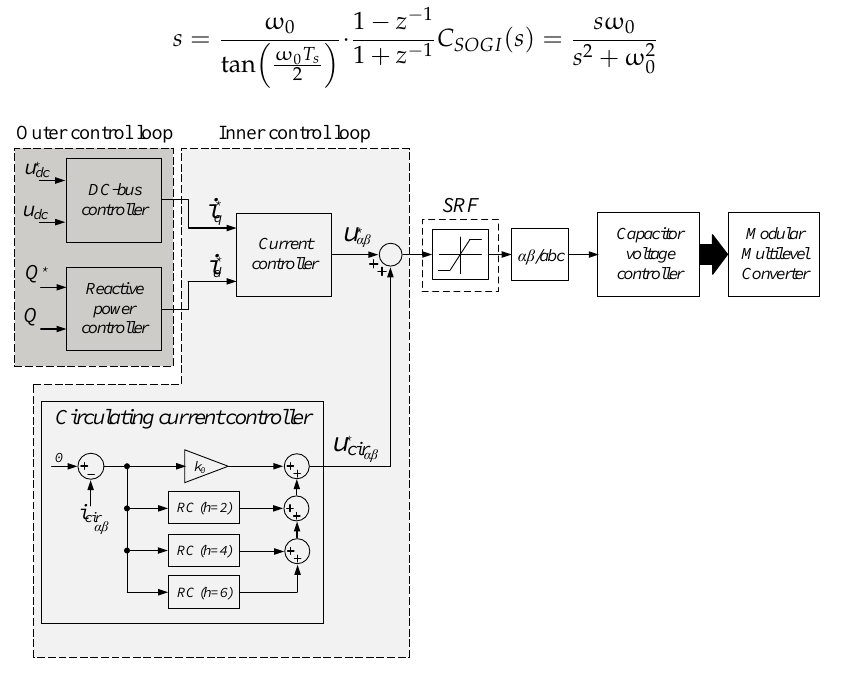
Figure 12. Overall control scheme based on resonant controllers.